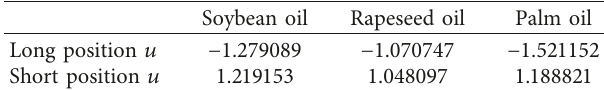
Table 5: Thresholds u selection.